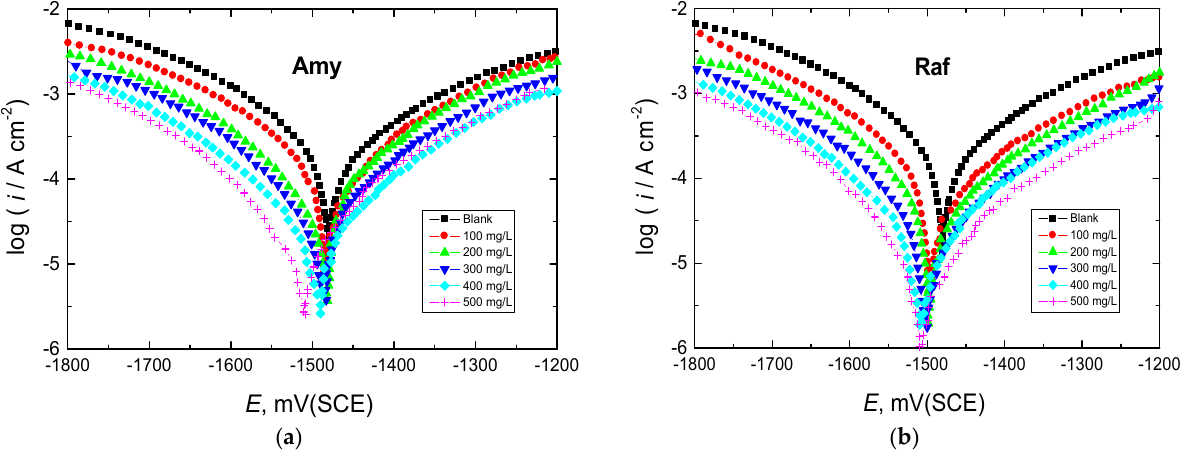
Figure 4. PDP curves for Al corrosion in 0.1 M NaOH medium and with, ( a ) Amygdalin (Amy), and ( b ) Raffinose (Raf) at 298 K.